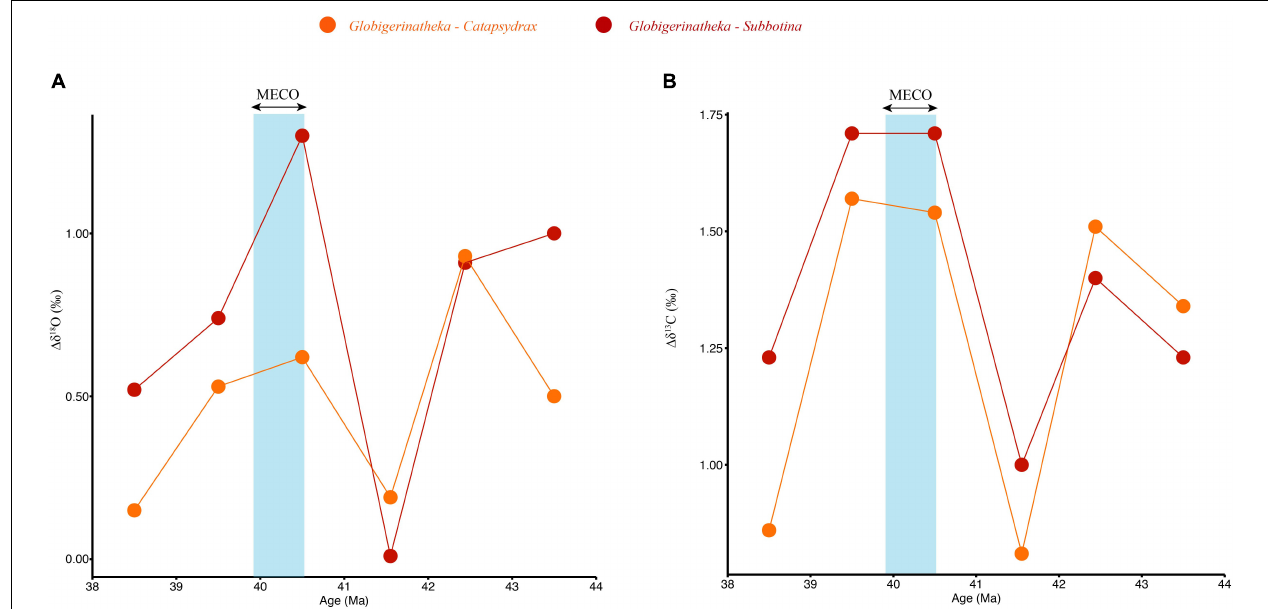
FIGURE 3 | Stable oxygen (A) and carbon (B) isotope gradients between Globigerinatheka (surface) and Subbotina (thermocline) and Catapsydrax (subthermocline) across the MECO interval. As the line approaches zero the isotopic gradient between the different genera is reduced, with 0 indicating no difference in isotopic signature between the different depth habitats. The vertical blue box indicates the MECO.